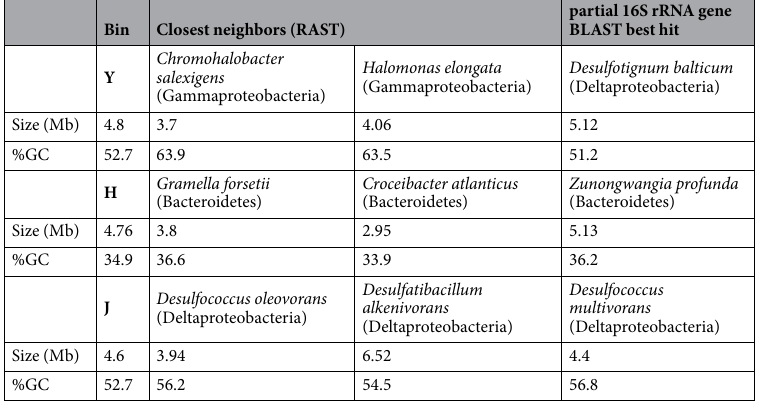
Table 1. Bin characteristics and similarities to known